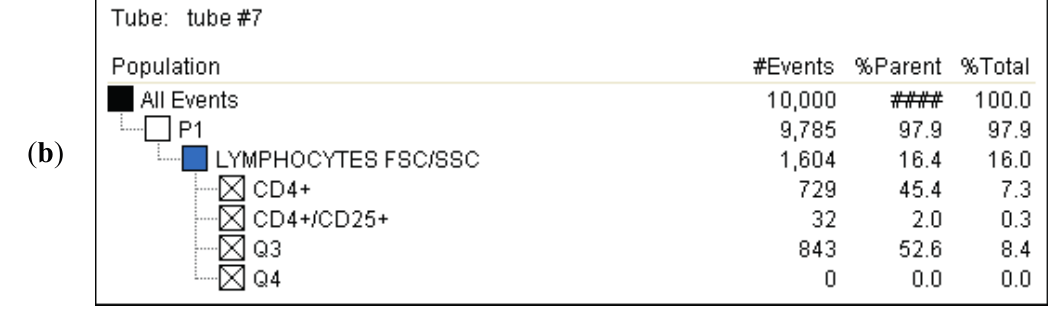
Figure 7. ( a ) Tube No. 7; Dot plot of CD25 FITC/CD4 PE with quadrant markers, showing Treg CD25 + /CD4 + lymphocytes; ( b ) Tube No. 7; Gating tree showing